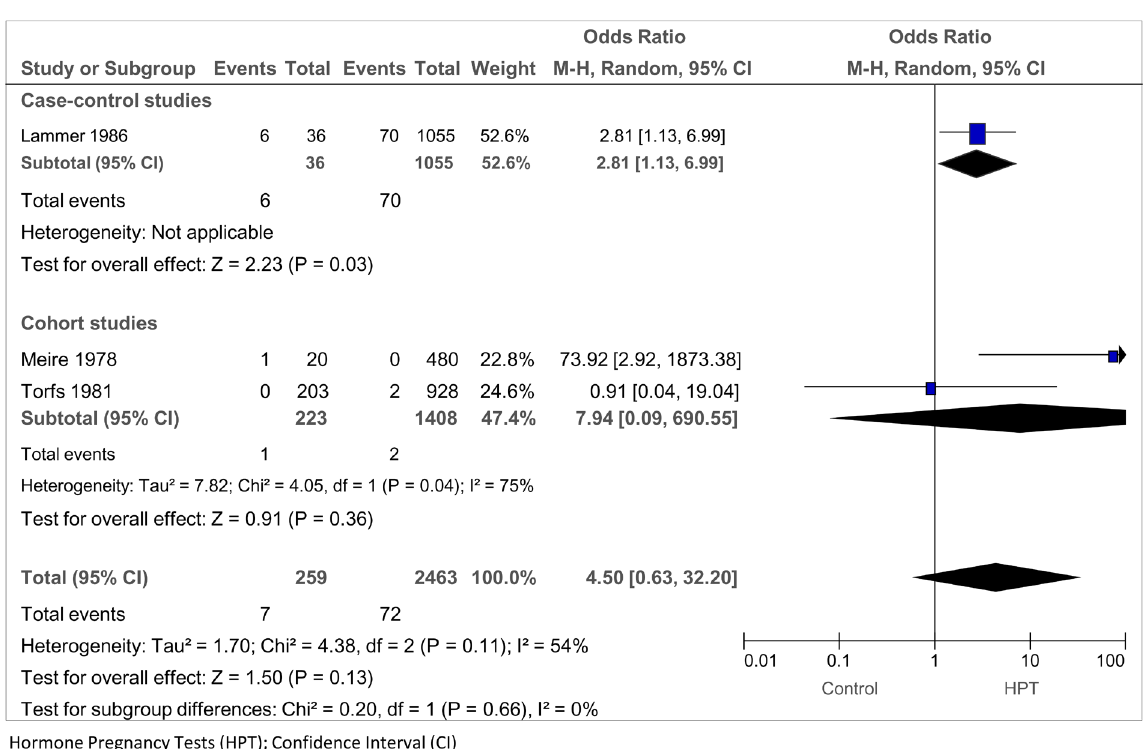
Figure 5. Association of exposure to oral hormone pregnancy tests (HPTs) in pregnancy and gastrointestinal malformations in the offspring.